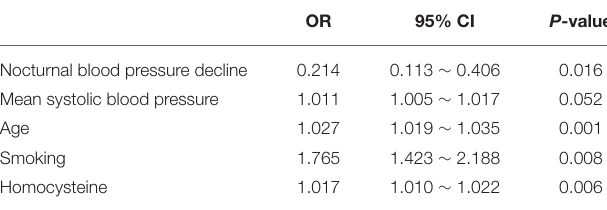
TABLE 5 | The multivariate logistic regression analysis between mixed and